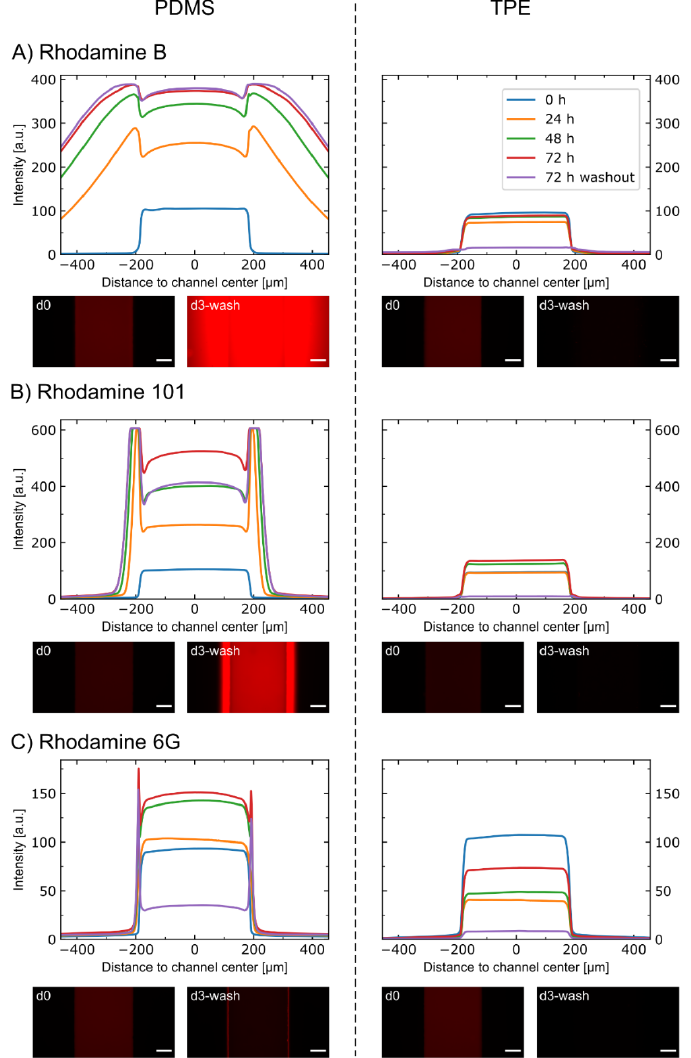
Figure 3. Absorption of rhodamine molecules into PDMS-based and TPE-based microfluidic de- vices. Average intensity profiles at different time points for chips incubated with ( A ) rhodamine B, ( B ) rhodamine 101, and ( C ) rhodamine 6G solutions. After 72 h of incubation, the solutions were washed out, and the remnant profile was acquired. Micrographs of the channels from day 0 (d0) and from day 3, after washout (d3-wash) are also shown. The scale bars refer to 100 µm. N = 2 for PDMS-rhodamine 6G 72 h and 72 h washout. All others are N = 3. In the TPE devices, there is no visible change in the signal profiles for all three tested molecules. In the PDMS devices, a high absorption of both rhodamine B and rhodamine 101 is evident, with the former appearing to have a higher absorption rate than the latter. Similarly, a partitioning of rhodamine 6G into the PDMS can be observed, yet to a much lower extent than for the other two dyes. The absorption of the three dyes is demonstrated not only by the increasing width of the profile over time but also by the remaining high intensity after washout. The increase in intensity over time in the main channel in the PDMS devices indicates an absorption into the PDMS also above the channel. However,